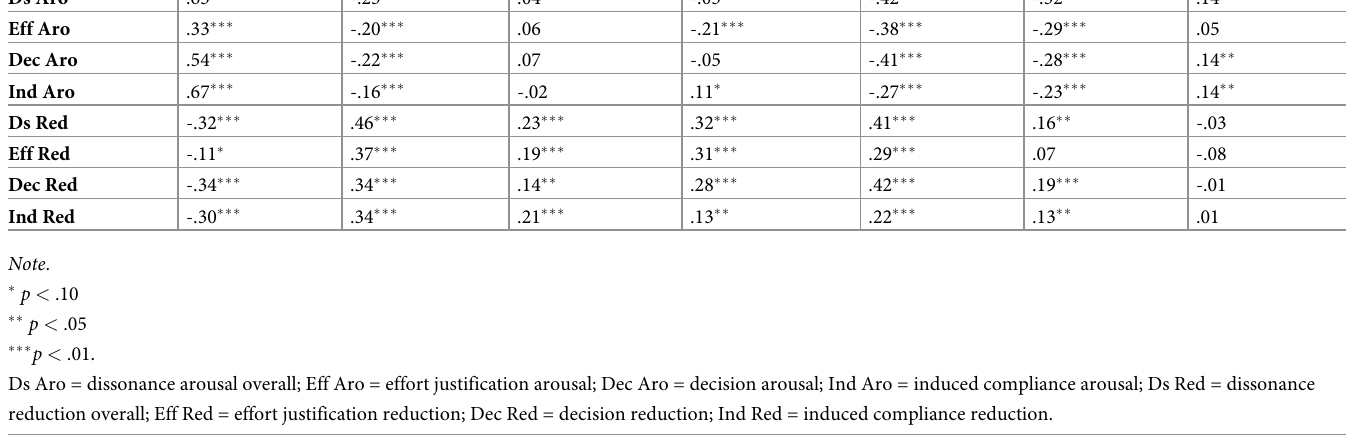
Table 15. Correlations of dissonance variables with BIS, BAS, SWLS, age, and gender (Study 3). BIS BAS-D BAS-FS BAS-RR Ds Aro .63 ��� .33 ��� .54 ��� .67